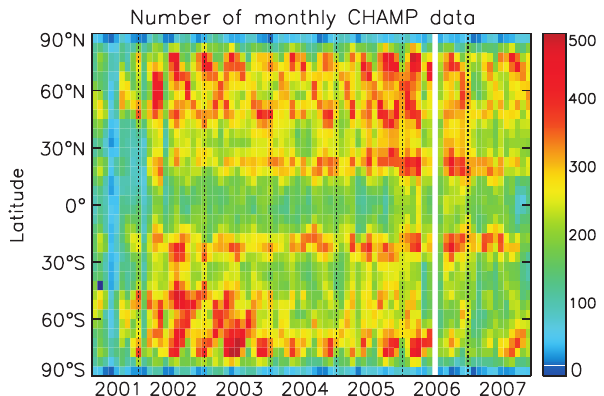
Fig. 1. Zonal monthly mean number of GPS RO CHAMP data from May 2001–December